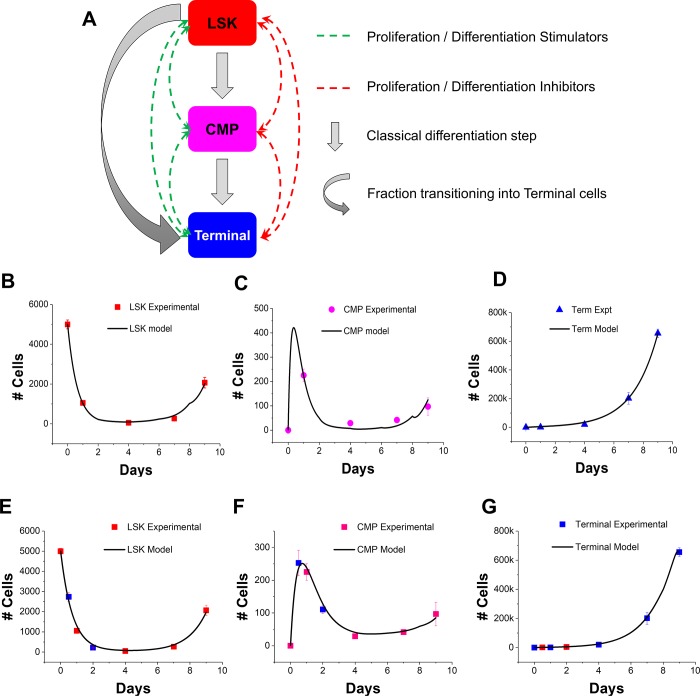
Computational set up of a 3-state cell model and experimental verification.(A) A 3-state computational model featuring the LSK, CMP and Terminal hematopoietic cells. Culture dynamics is influenced via feedback from cell-secreted biomolecules that stimulate and/or inhibit the proliferation and differentiation rates of each cell type. Additionally, a fraction of LSKs would be available to transition directly into Terminal (‘jump’). (B-D) The model simulation is able to capture the dynamics and scale of the experimental data for all 3 cell profiles (B: LSK; C: CMP; D: Terminal). The initial model further predicted a peak in CMP population prior to day 1 of culture. (E-G) Further experiments were performed to capture data before and after the 1 day data point (12hr; 48hr) for all three cell sub-populations (E: LSK; F: CMP; G: Terminal) to substantiate the initial model predictions. Error bars represent standard error of mean.